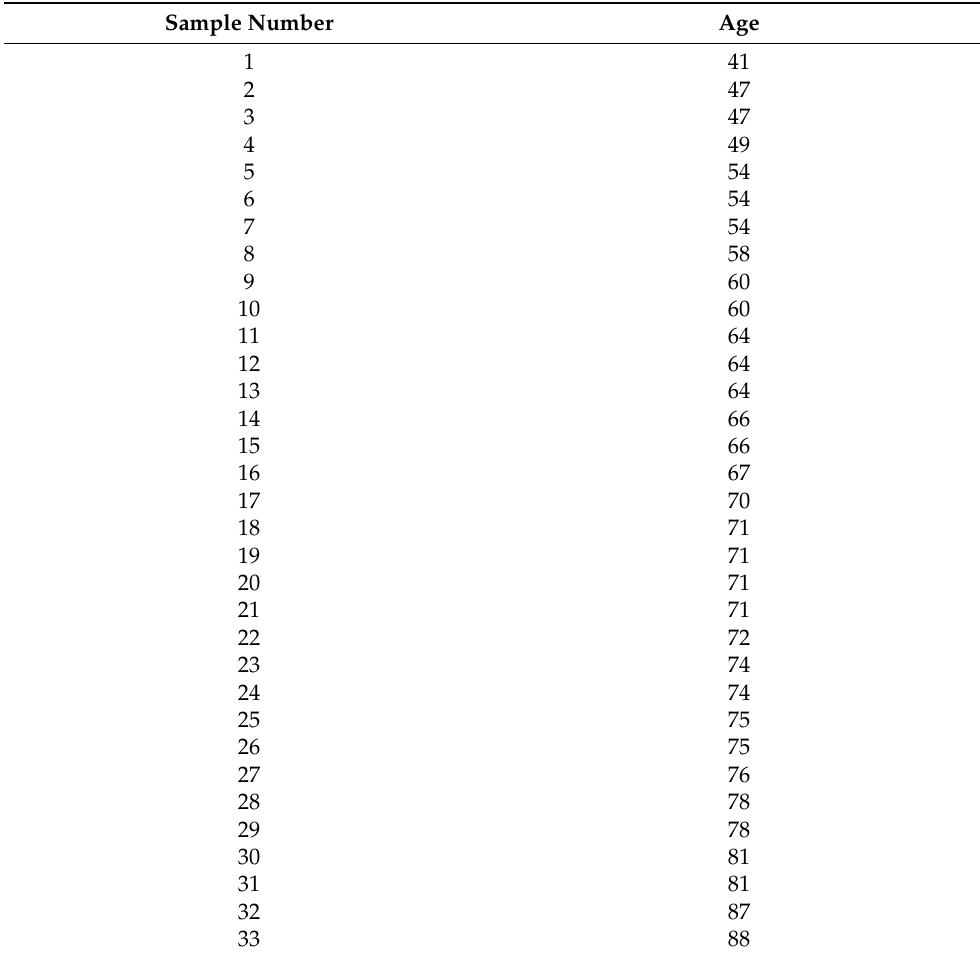
Table A2. Male specimens included in the non-diseased